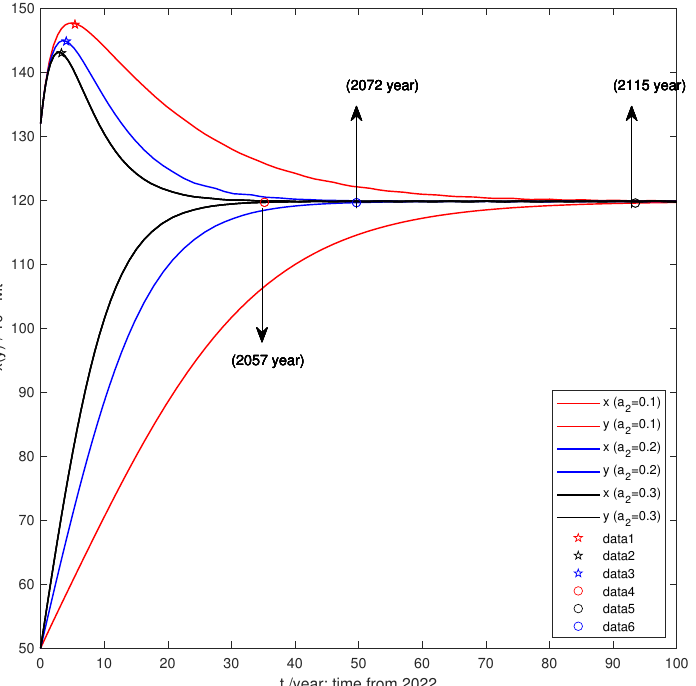
Figure 5. Analysis of the influence of natural growth rate of carbon absorption on carbon absorption and